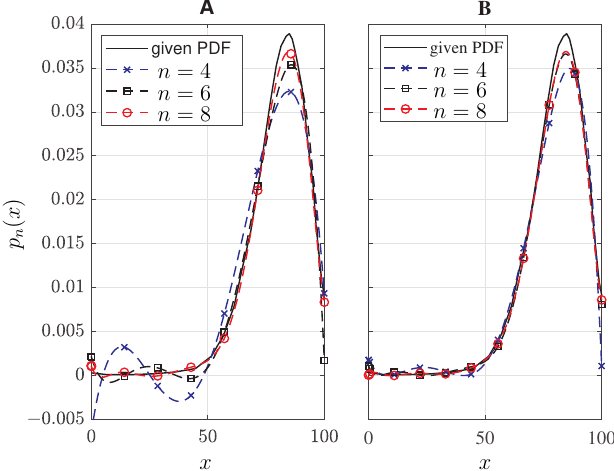
Figure 7. The approximations of a given PDF by polynomial PDFs, p n ( x ) , with n = 3,5, and 7 using the unconstrained ( A ), and constrained ( B ) LS approximation, respectively.